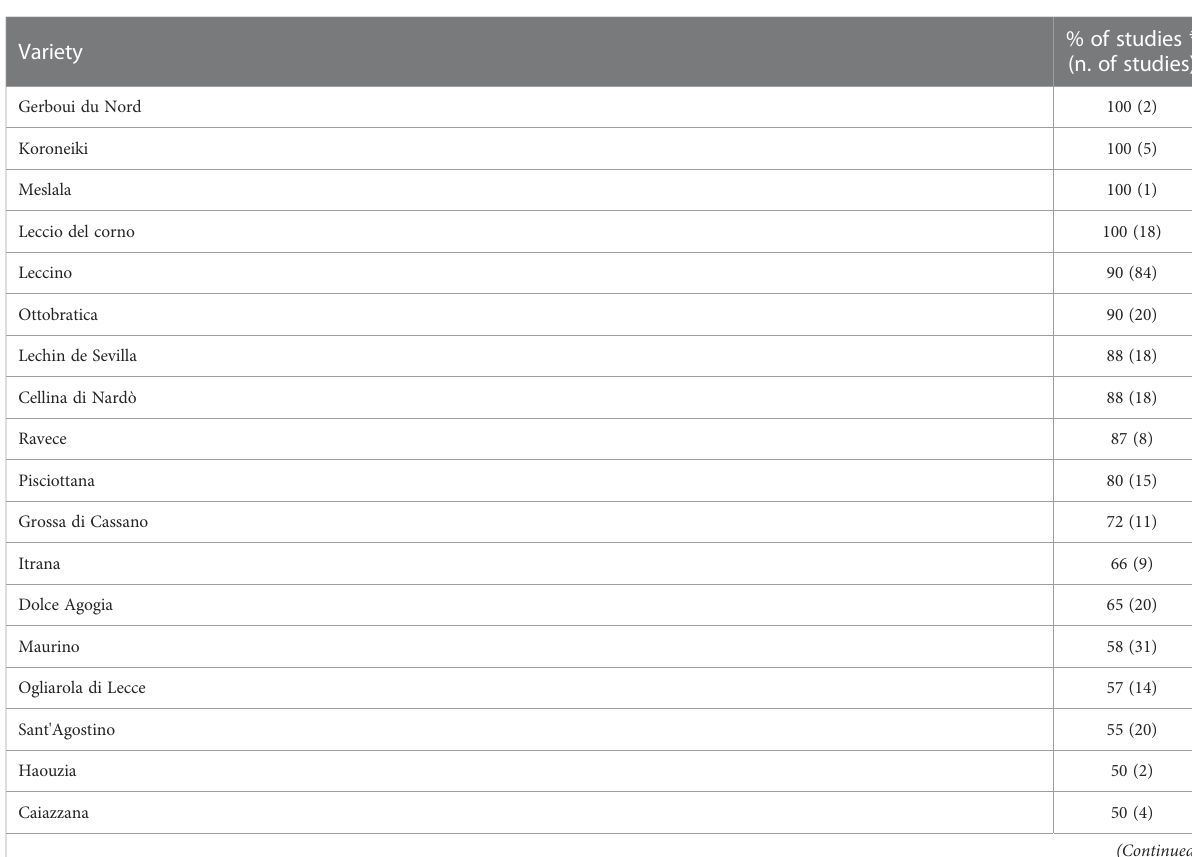
TABLE 1 Main olive varieties with low foliar susceptibility to Venturia oleaginea .